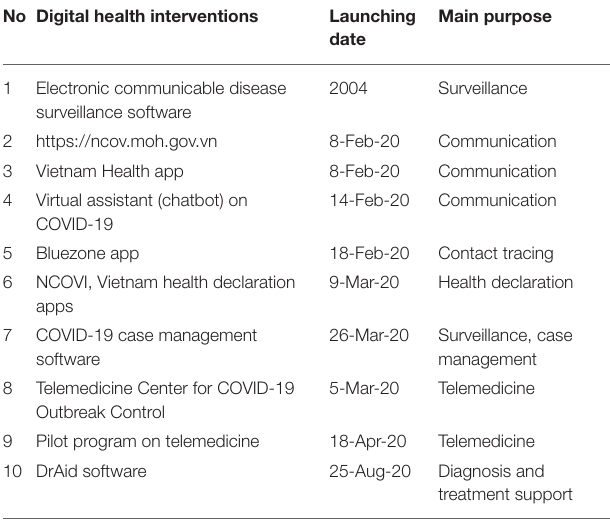
TABLE 1 | List of digital Health applications in addressing COVID-19 in